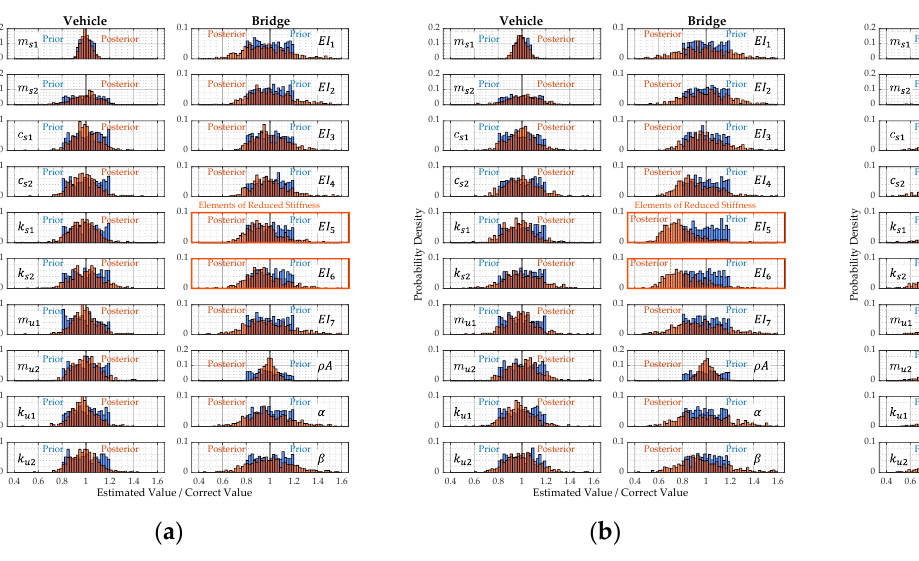
Figure 14. The application results of the PRE method: ( a ) Scenario 4 (stiffness decrease section: 3𝐿/7 ~ 4𝐿/7 , decrease ratio: 10%); ( b ) Scenario 5 (stiffness decrease section: 3𝐿/7 ~ 4𝐿/7 , decrease ratio: 30%); and ( c ) Scenario 6 (stiffness decrease section: 3𝐿/7 ~ 4𝐿/7 , decrease ratio: 60%).